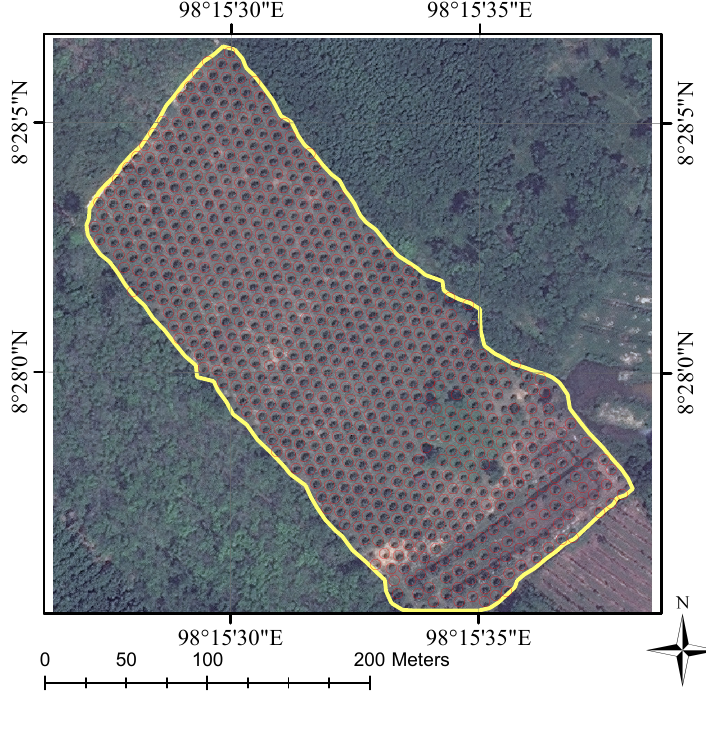
Figure 6. The oil palm tree detection result on the test area shown in Figure 4a. The detected oil palm trees from the proposed method are marked with red circles. Note that the diameter of red circles has no relationship with the diameter of tree